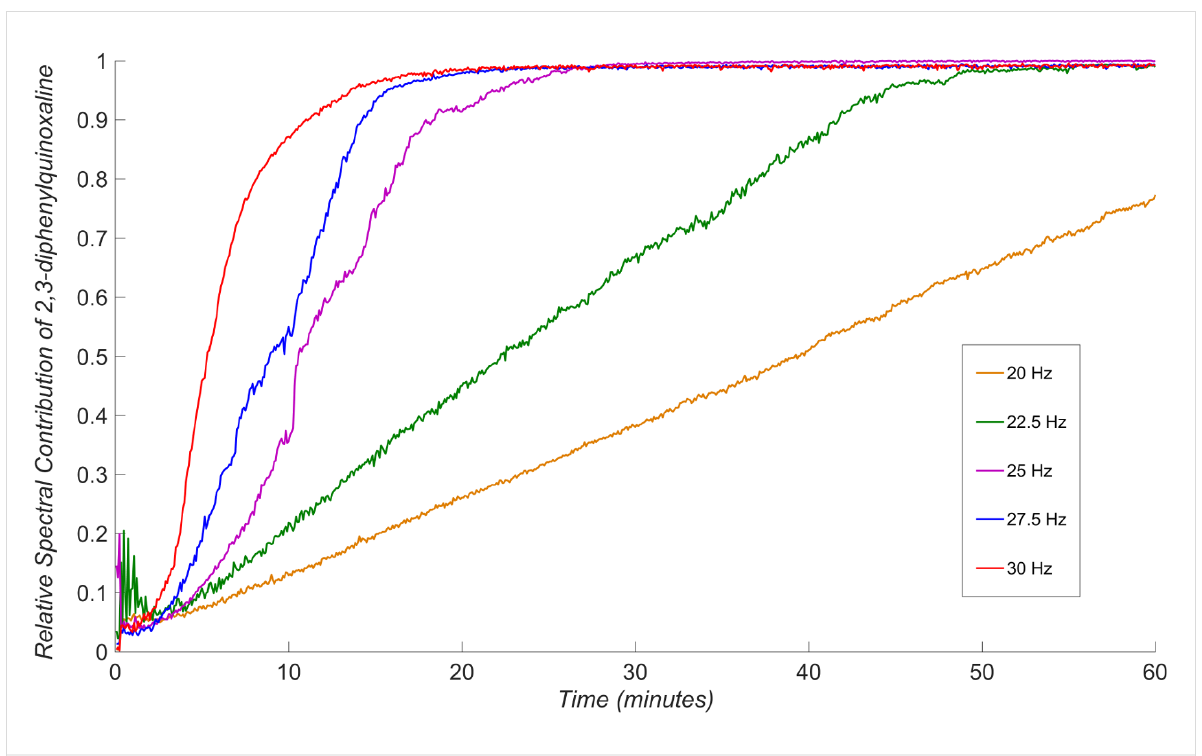
Figure 4: The effect of milling frequency on the milling condensation of benzil and o- phenylenediamine to form 2,3-diphenylquinoxaline, with data for each milling frequency averaged from a set of triplicate measurements. Variation close to the onset of milling may be due to poor initial homogeneity of the sample.